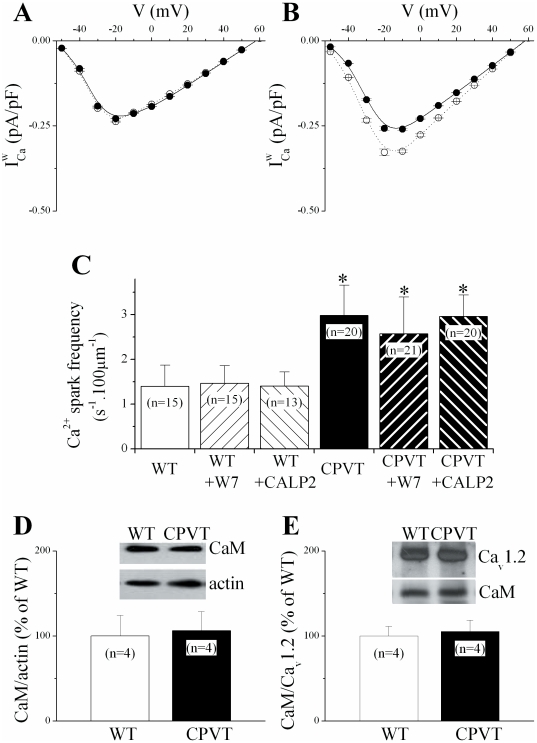
Calmodulin inhibition reduced  in WT cells.
A & B. CaM antagonists, W7 (A) or CALP2 (B) reduced  in WT cells (dashed line) without affecting it in CPVT cells (continuous line). C. Comparison of the Ca2+ sparks occurrence at rest in myocytes from WT (open bars) and CPVT (closed bars) cells in control conditions and after incubation with W7 (left hatched bars) or CALP2 (right hatched bars). * P<0.05 vs WT. D & E. Representative immunoblots and quantification of CaM protein levels in cardiac heart lysates (D, normalized to the corresponding actin level and normalized to respective controls) and detected in the membrane fraction (E, normalized to the corresponding Cav1.2 level and normalized to respective controls) from WT (open bars, n = 4) and CPVT (closed bars, n = 4) mice.